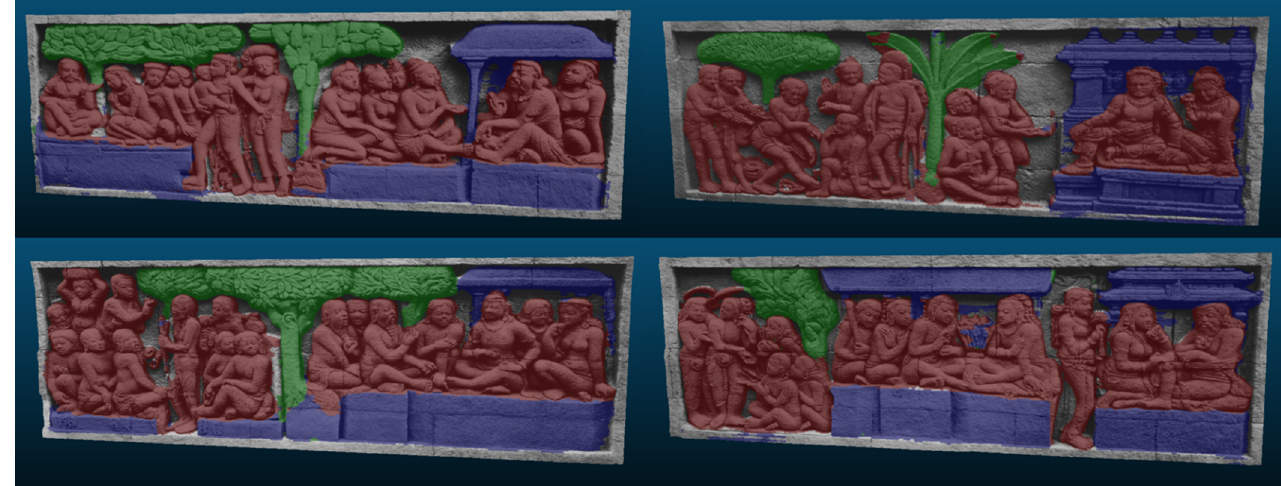
Figure 13. Samples of visualization results.